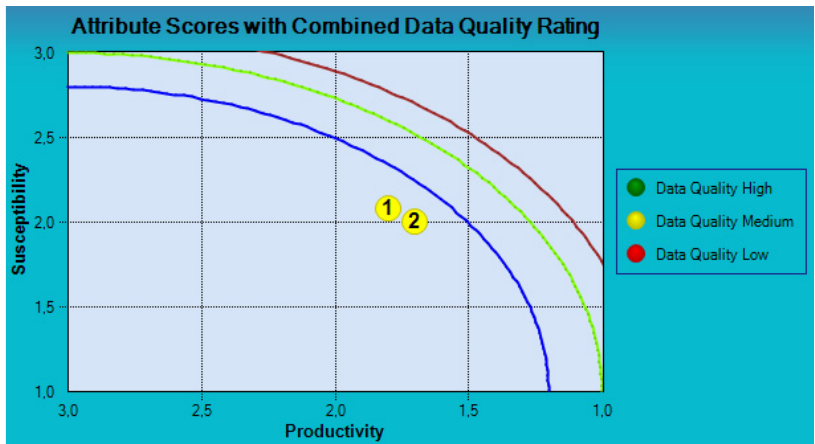
Fig. 5: The results of the susceptibility and productivity analysis of red and black groupers. Table 5: Susceptibility index of red and black Groupers at Wakatobi National Park Table 5: Susceptibility index of red and black Groupers at Wakatobi National